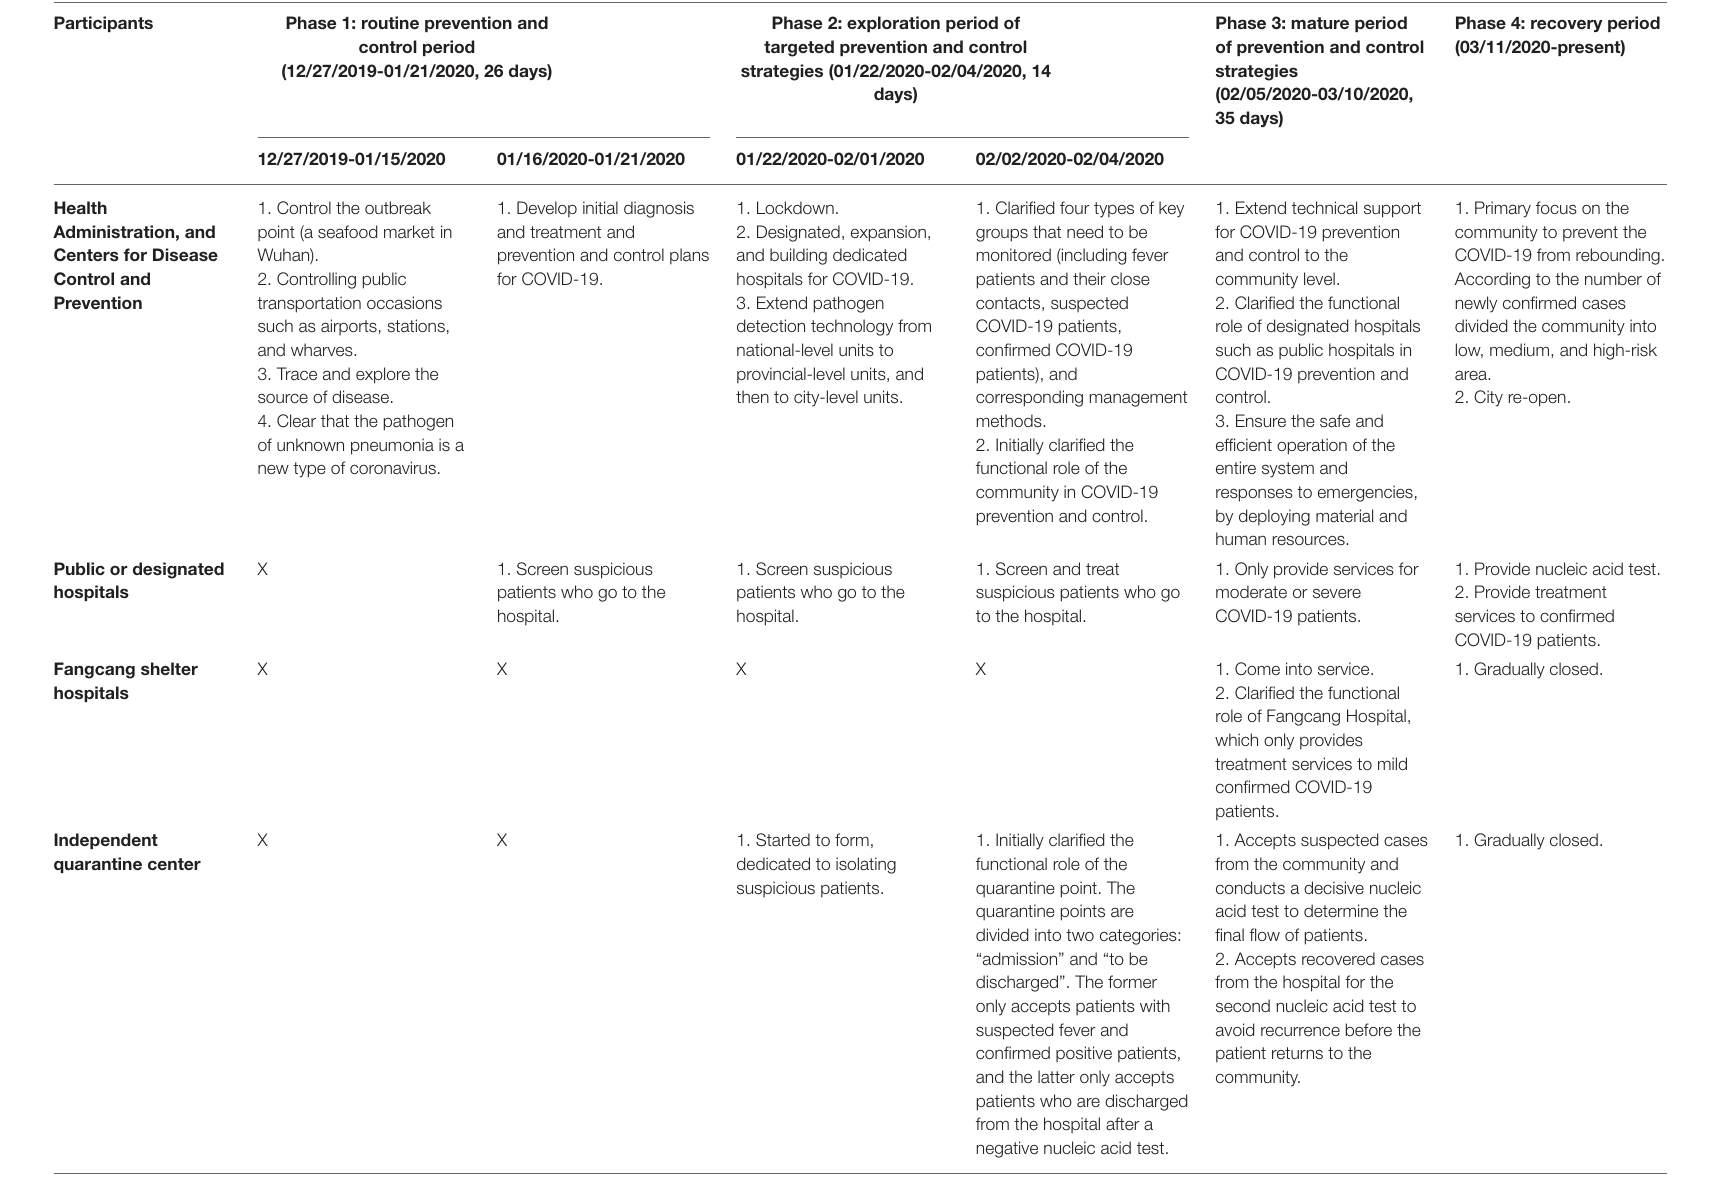
TABLE 1 | Participants and corresponding strategies of COVID-19 prevention and control in Wuhan †‡ .